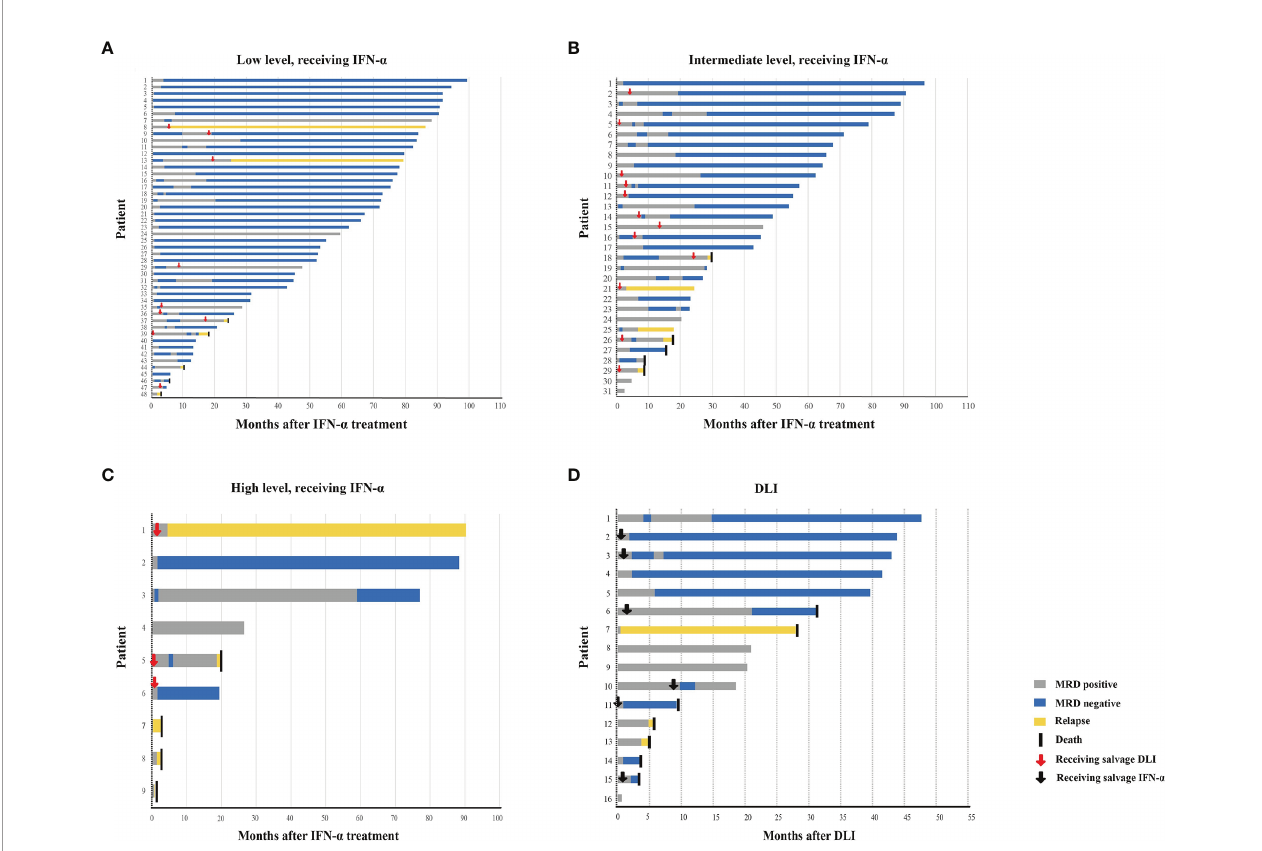
FIGURE 2 | Response. Swimmer plot displayed patients receiving preemptive IFN- a therapy with low-level RUNX1-RUNX1T1 (A) , intermediate-level RUNX1- RUNX1T1 (B) , and high-level RUNX1-RUNX1T1 transcripts (C) , respectively, and patients receiving preemptive DLI (D) . IFN, interferon; DLI, donor lymphocyte